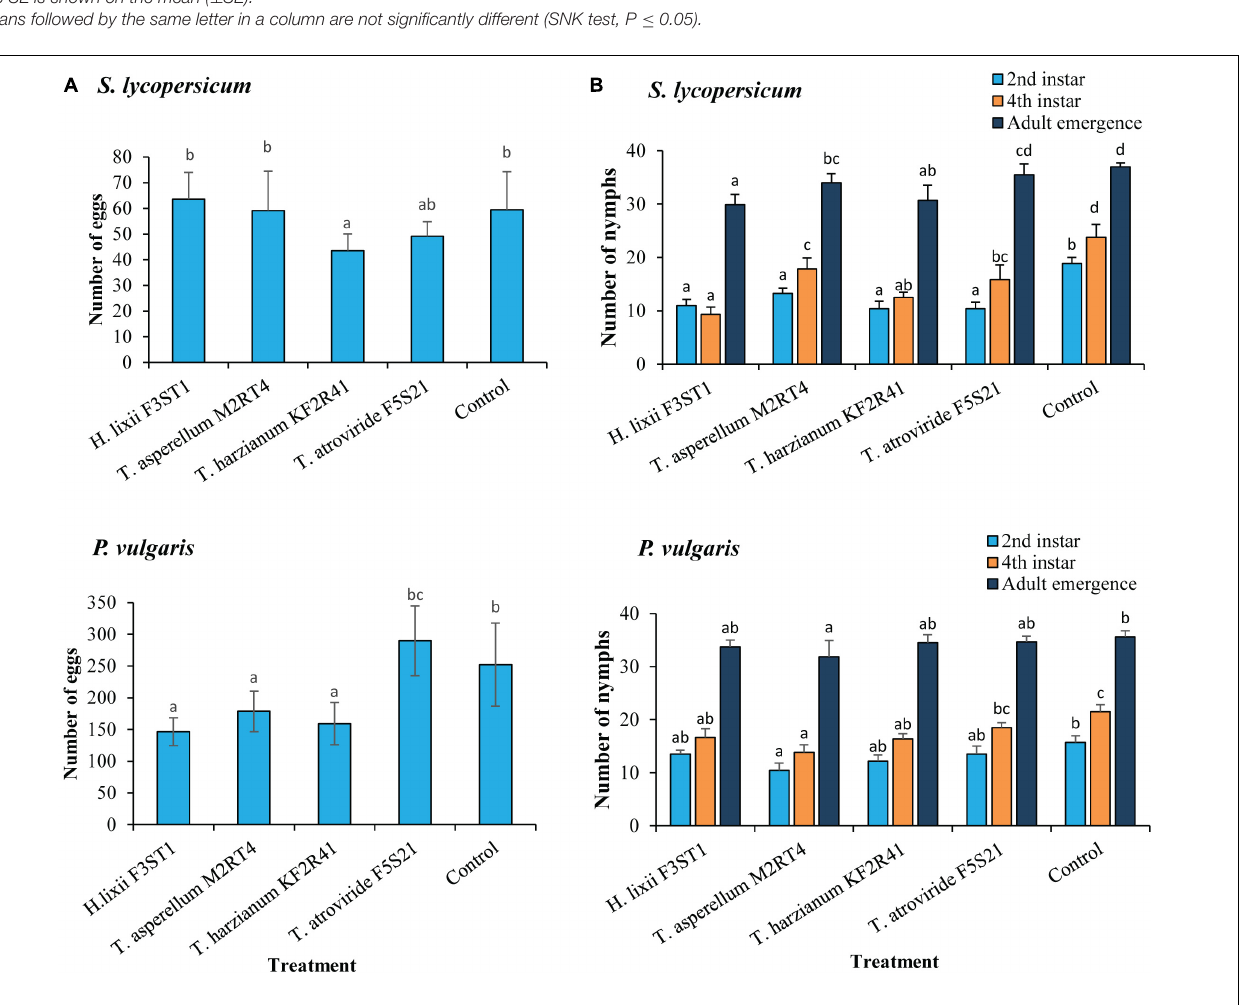
test = 328, df = 4, P < 0.0001) and P. vulgaris (proximate